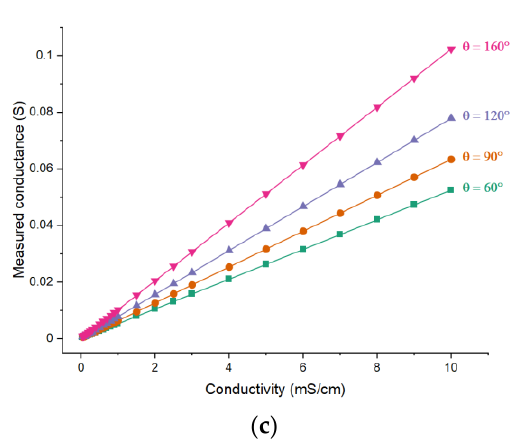
Figure 10. Simulation results for different electrode angles: The dependence of ( a ) the real part of the impedance; ( b ) the imaginary part of the impedance; ( c ) the measured conductance on the conductivity of the solution when L/d = 6.